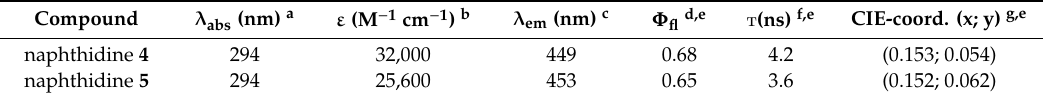
Table 2. Photophysical data of the naphthidines 4 and 5 .